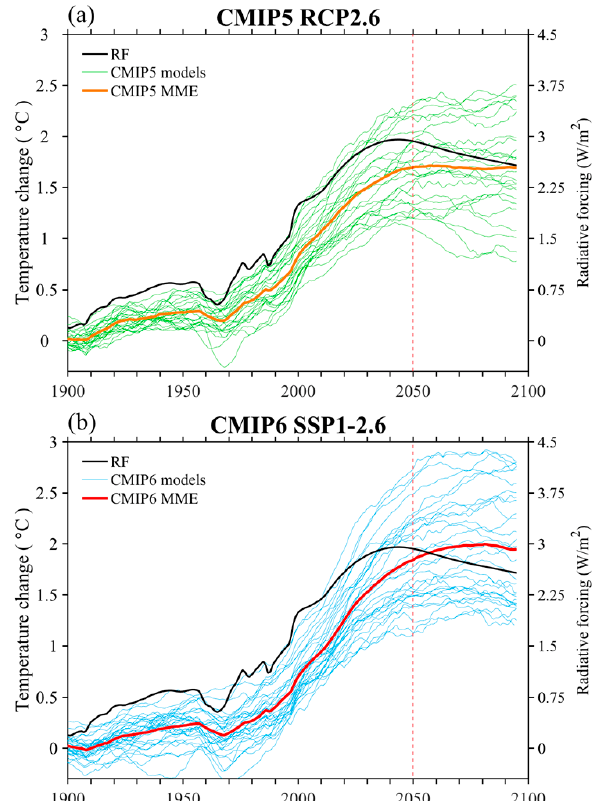
Figure 1. Global-mean annual-mean surface temperature change ( ◦ C) relative to preindustrial level (1850–1899 mean) in each model (colored thin lines) and its multi-model ensemble mean (MME) results (colored thick lines) in ( a ) CMIP5 and ( b ) CMIP6. The black thick lines indicate the radiative forcing (RF, W m − 2 ) pathway, and the red dotted lines indicate the time of year 2050. Monthly mean outputs of 25 models from CMIP5 and 30 models from CMIP6 (Table 1), including surface temperature, precipitation, evaporation, vertical velocity and winds are used. Some models conduct several members of the historical and scenario experiments, to ensure equal weight, only one member of each CMIP model is analyzed to ensure equal weight. All model outputs are interpolated onto a common 2 ◦ longitude × 2 ◦ latitude grid by linear method for easy comparison, the analyses based on the interpolated grids cause only slight differences from those based on model’s original grids over ISM regions (not